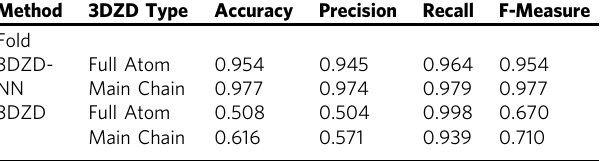
Fig. 5d show cases where 3DZD had a slightly higher score than the threshold and considered them as the same fold while 3DZD- NN considered them as different folds. In both cases, while 3DZD